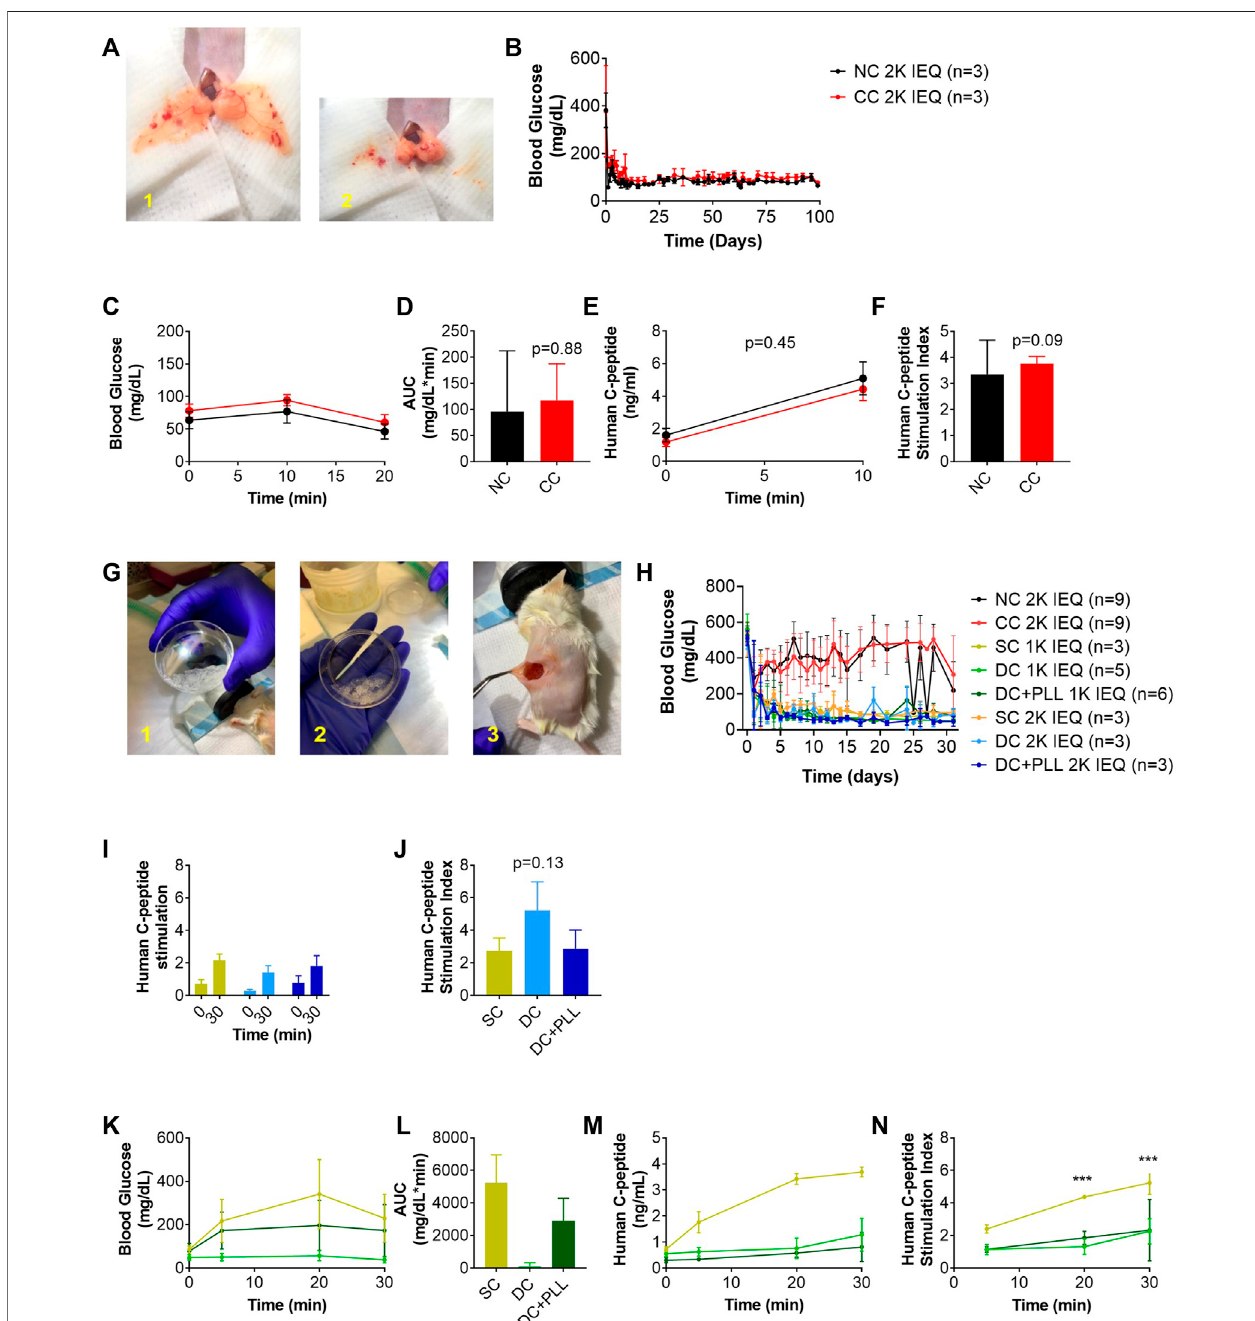
FIGURE 4 | In vivo function of CC and alginate microencapsulated human islets compared to non-coated islets transplanted in their traditional site in diabetic mice (A – N) . 2k IEQ human islets (NC HIs, black) and 2k IEQ HIs encapsulated through conformal coating (CC, red) transplanted in the fat pad (A) of diabetic NOD-scid mice. 2k IEQ or 1k IEQ HIs encapsulated in single capsules (SCs, yellow) and 2 or 1k IEQ double capsules (DCs) without PLL (light blue and light green, respectively), and 2 or 1k IEQ double capsules (DCs) with PLL (dark blue and dark green, and orange, respectively) transplanted in the peritoneal cavity of diabetic NOD-scid mice (G) in two separate experiments. Blood glucose (BG) (B) and glucose tolerance (IPGTT) (C) POD 30 (NC HIs, black; CC, red); AUC (D) human c-peptide (E) , c-peptide index (NC HIs, black; CC, red) of mice receiving NC or CC (F) . BG (H) , human c-peptide (I) , c-peptide index (J) , and IPGTT (K) at POD 31; AUC (L) ; human c-peptide (M) , c-peptide index (N) of mice receiving NC, CCs, SCs, DCs or DC + PLL. Data are average ±SD for n = 3 – 6 mice per group.